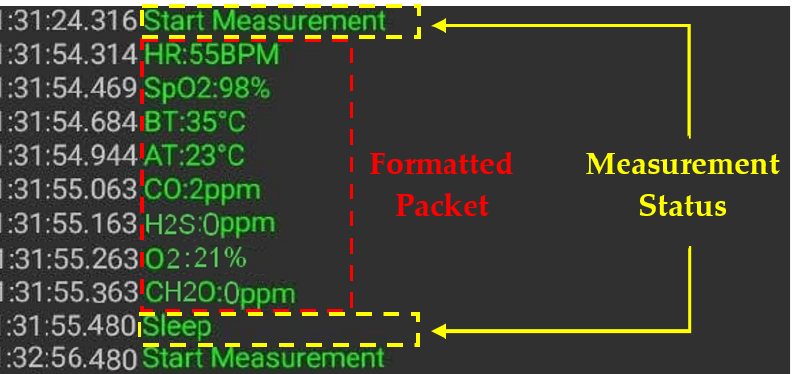
Figure 16. Screenshots of the Serial Bluetooth Terminal with the connection status and the packet streams.